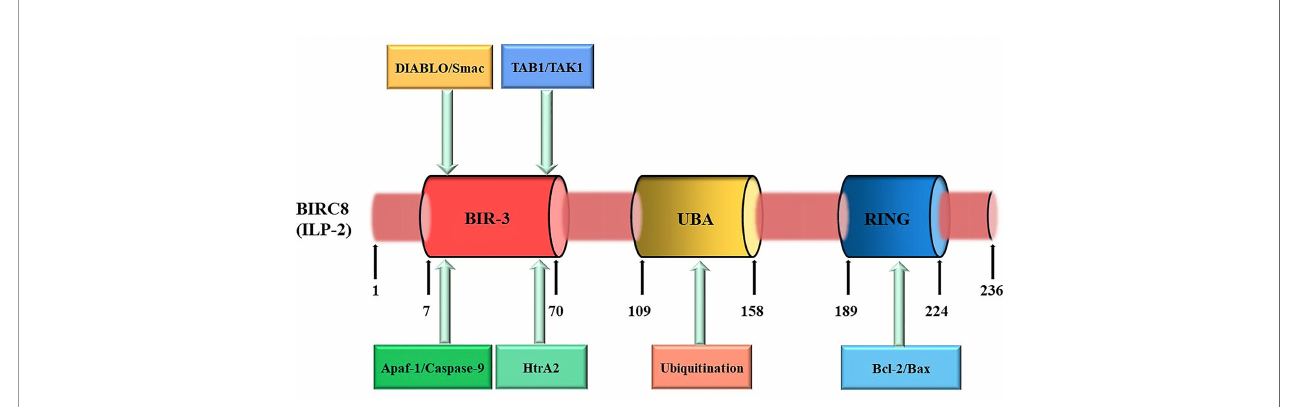
FIGURE 2 | ILP-2 protein structure and function. ILP-2 (also kwon as BIRC8) protein structure presents 236 amino acids and is composed of a Baculovirus IAP Repeat (BIR) domain, an Ubiquitin-associated (UBA) domain, and a RING fi nger domain. Each structural domain of ILP-2 is capable of binding to the corresponding protein to perform the relevant function. The numbers refer to